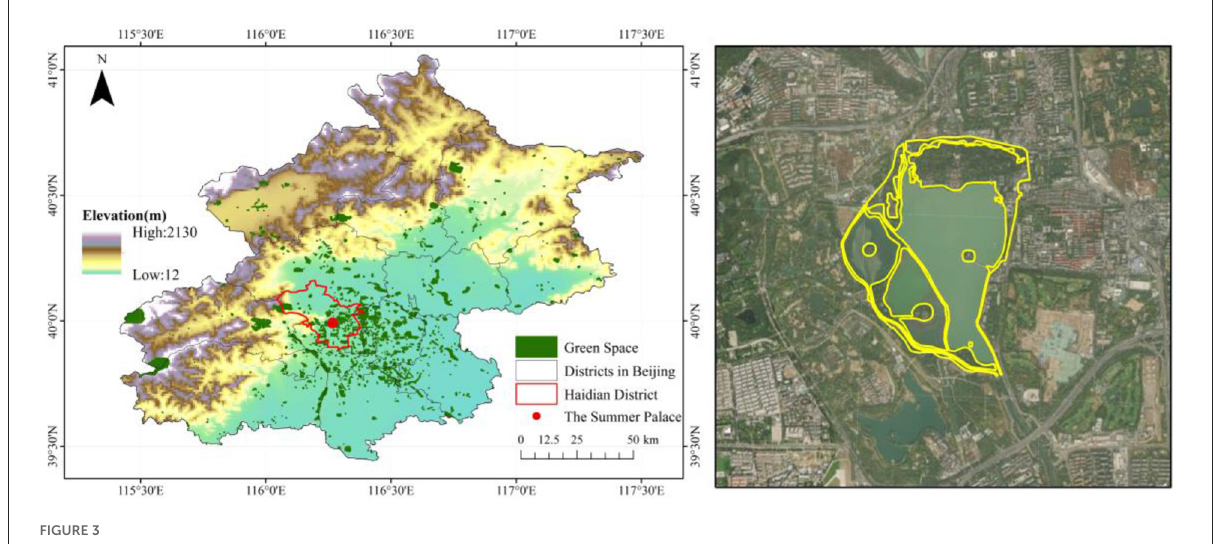
FIGURE3 The geographical location of the Summer